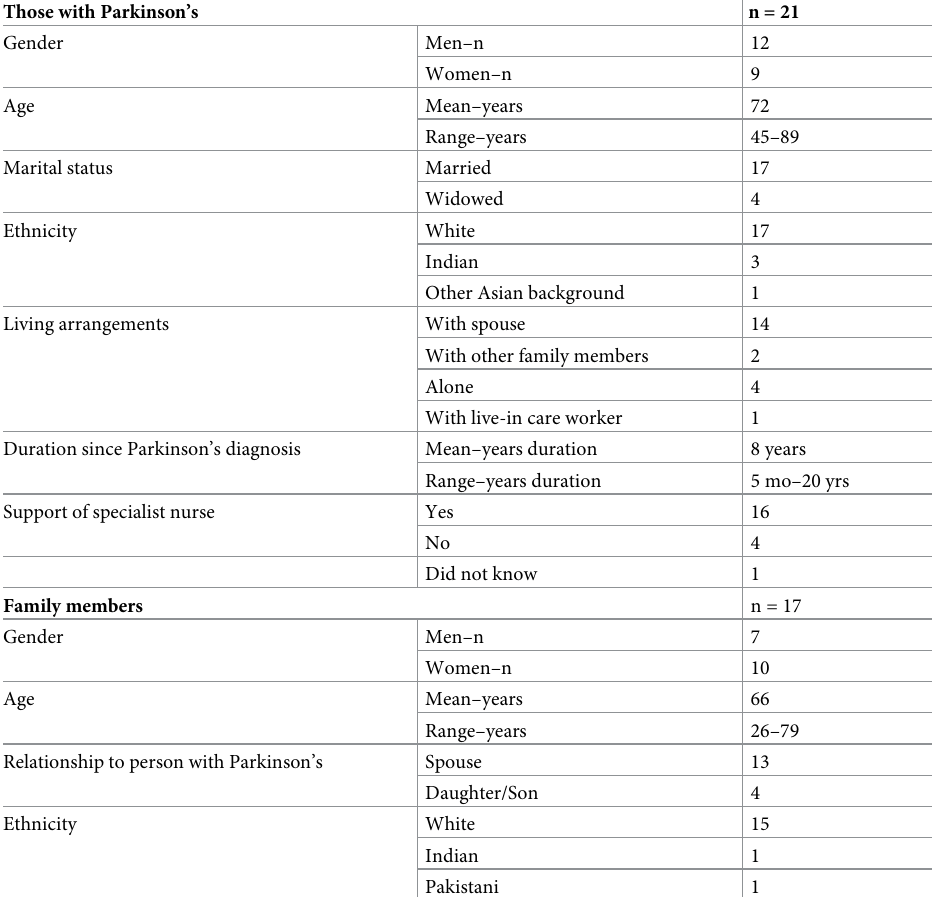
Table 1. Participants’ demographic details and Parkinson’s characteristics (n =